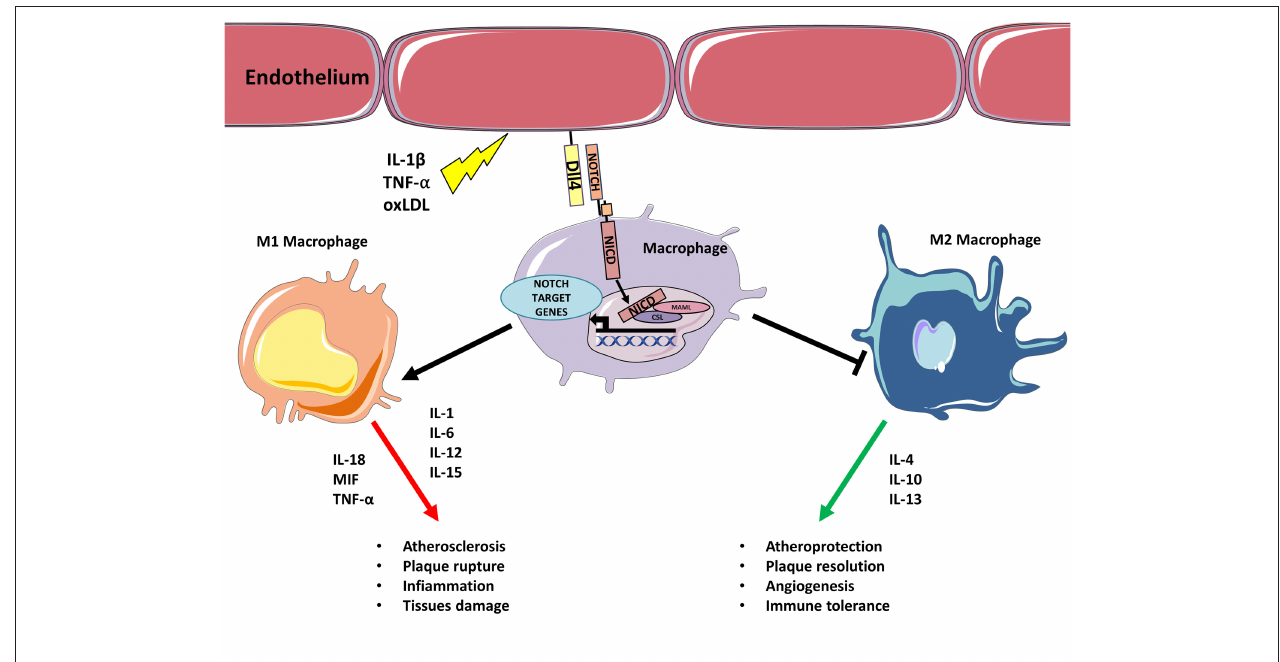
FIGURE 1 | Inflammatory stimulus triggers M1 polarization via Notch. Inflammatory stimulus, such as IL-1 β , TNF- α , oxLDL upregulates Dll4 on endothelial cells (or APCs). Binding between endothelial Dll4 (and possibly Dll1) and Notch1 or Notch3 in macrophages initiates Notch program that results in macrophages M1 polarization and concomitant inhibition of M2 differentiation. M1 activated macrophages feed inflammation and atherosclerosis by secreting further inflammatory cytokines, Notch blocks M2 polarization inhibiting M2 capacity to resolve inflammation/lesion.